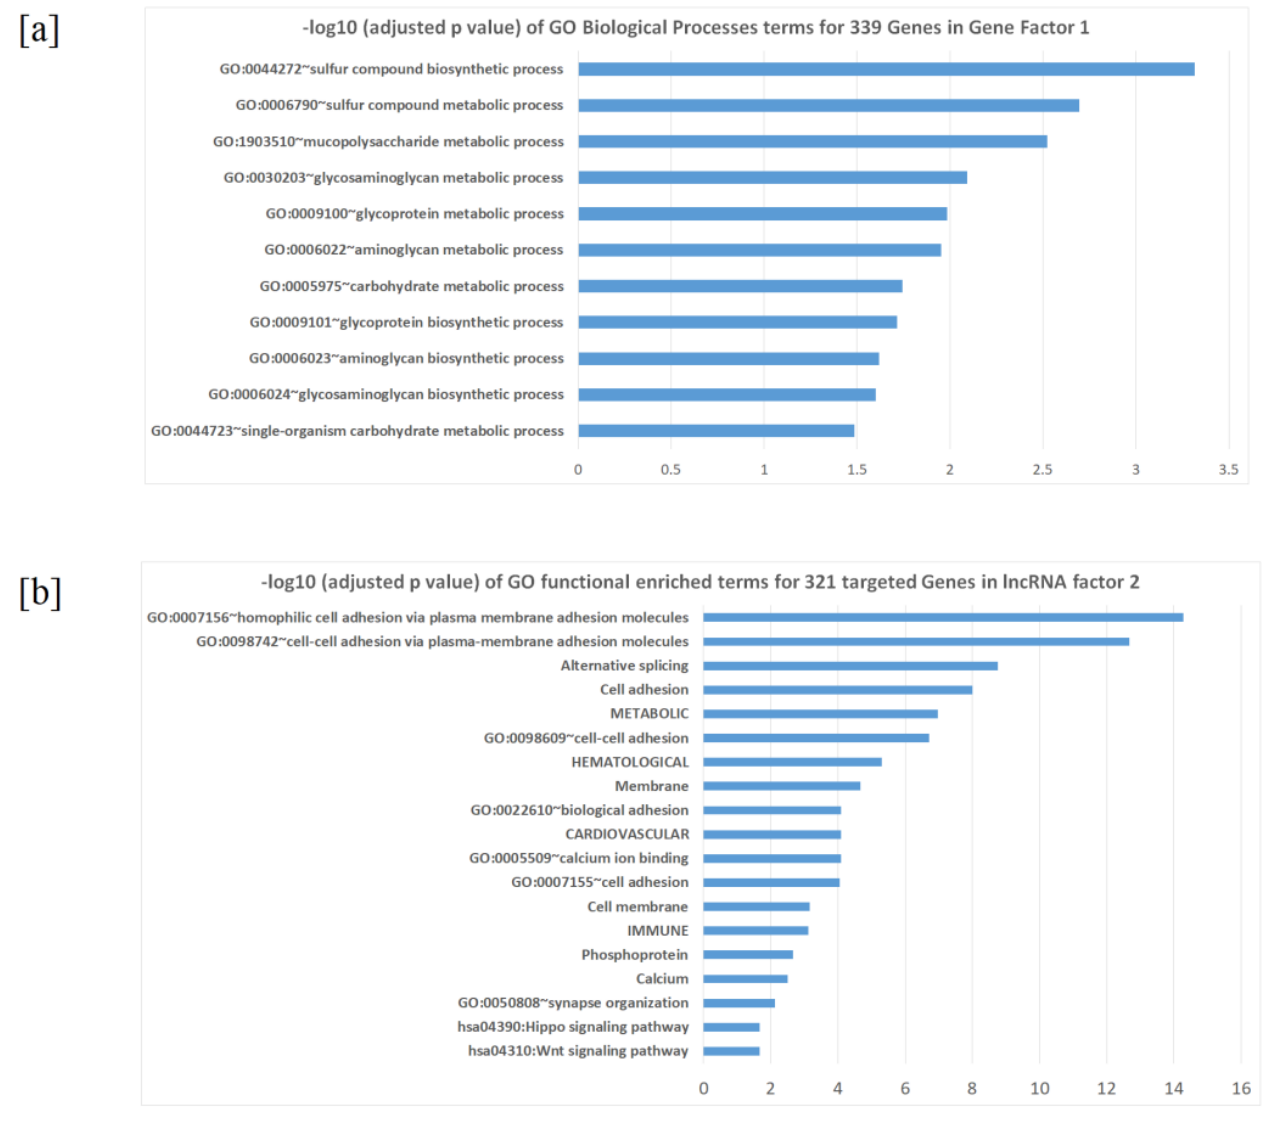
Figure 3. -Log10 (Adjusted p value) scale for enriched functional pathways: ( a ) gene factor 1; ( b ) targeted genes in lncRNA factor 2.